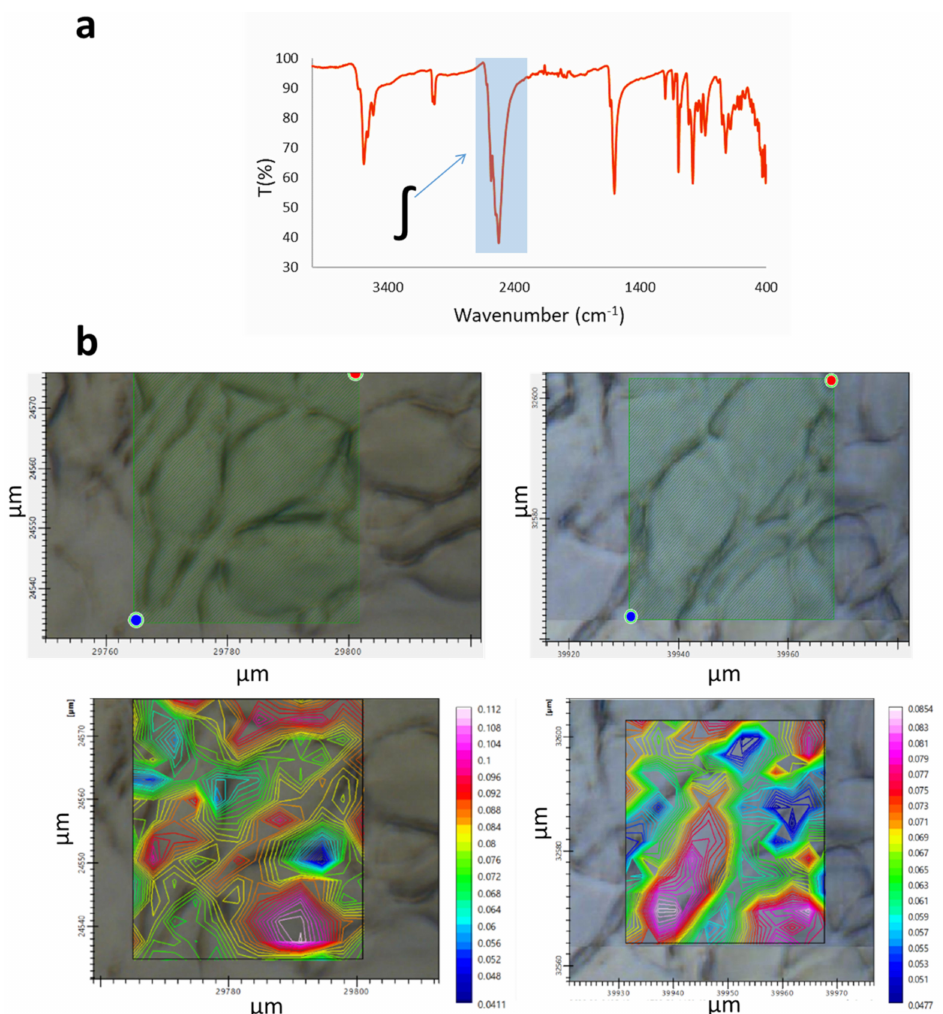
Figure 6. Microscopy images of GIC7 cells treated with Na[o-COSAN] 2 mM, 5 h and mappings were obtained by integrating the ν (B-H) signals between 2620 and 2460 cm − 1 spectra ( a ). Two different areas of culture cells are shown with the corresponding maps ( b ). The red color intensity is proportional to Na[ o -COSAN] spectra suggesting the nuclear localization of the